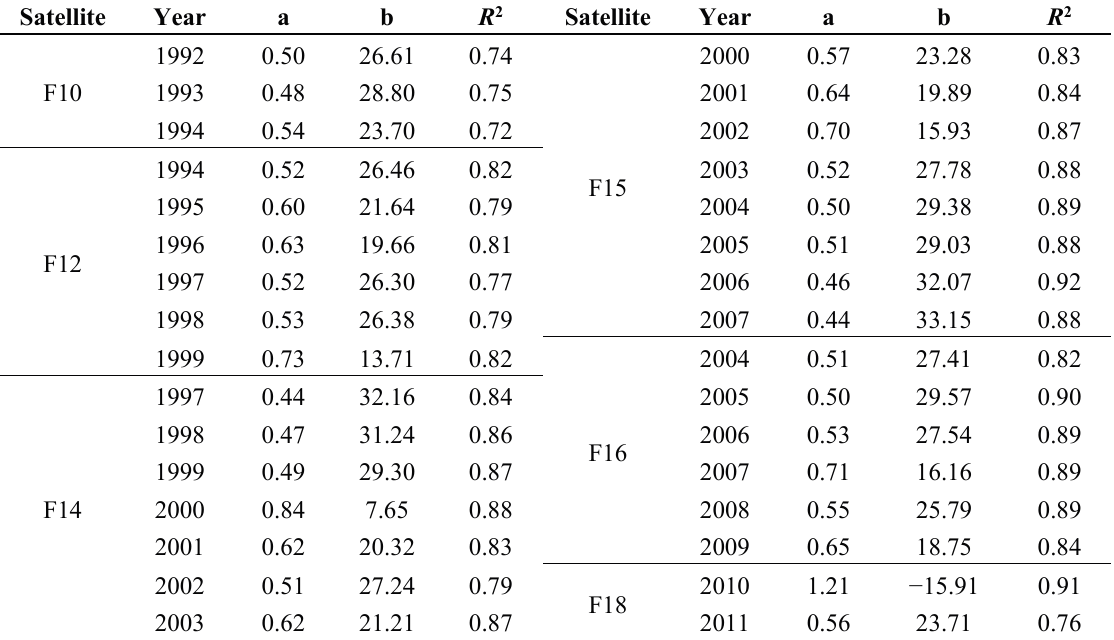
Figure 3. Examples of DN values in the urbanization area from different satellites before calibration during 1992–2012. Table 3. Coefficients of the simplified linear regression models for NTL from 1992 to 2012.